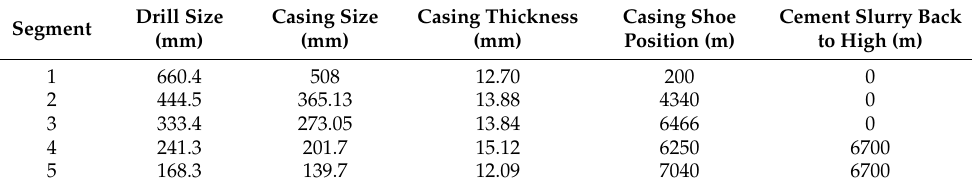
Table 2. Wellbore structure parameters of the high-pressure gas well.